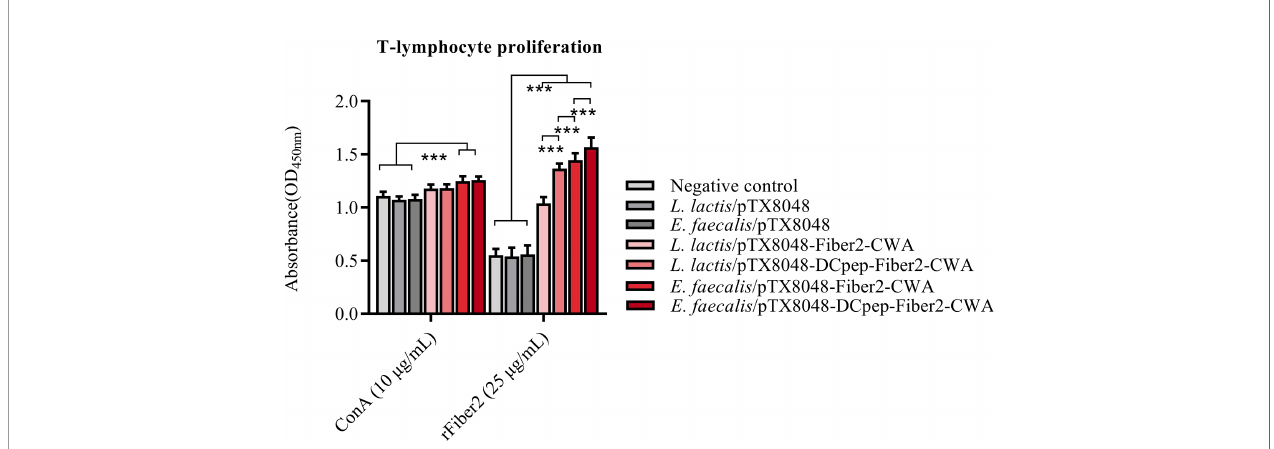
FIGURE 6 | Detection of T lymphocyte proliferation. At 2 weeks after the third immunization, T lymphocytes were isolated from the peripheral blood of fi ve chickens (n = 5) from each group. The proliferation of isolated T lymphocytes was assessed using a CCK-8 assay kit, and rFiber2 protein and ConA were selected as stimuli, respectively. Data are presented as mean ± SD. *** p <